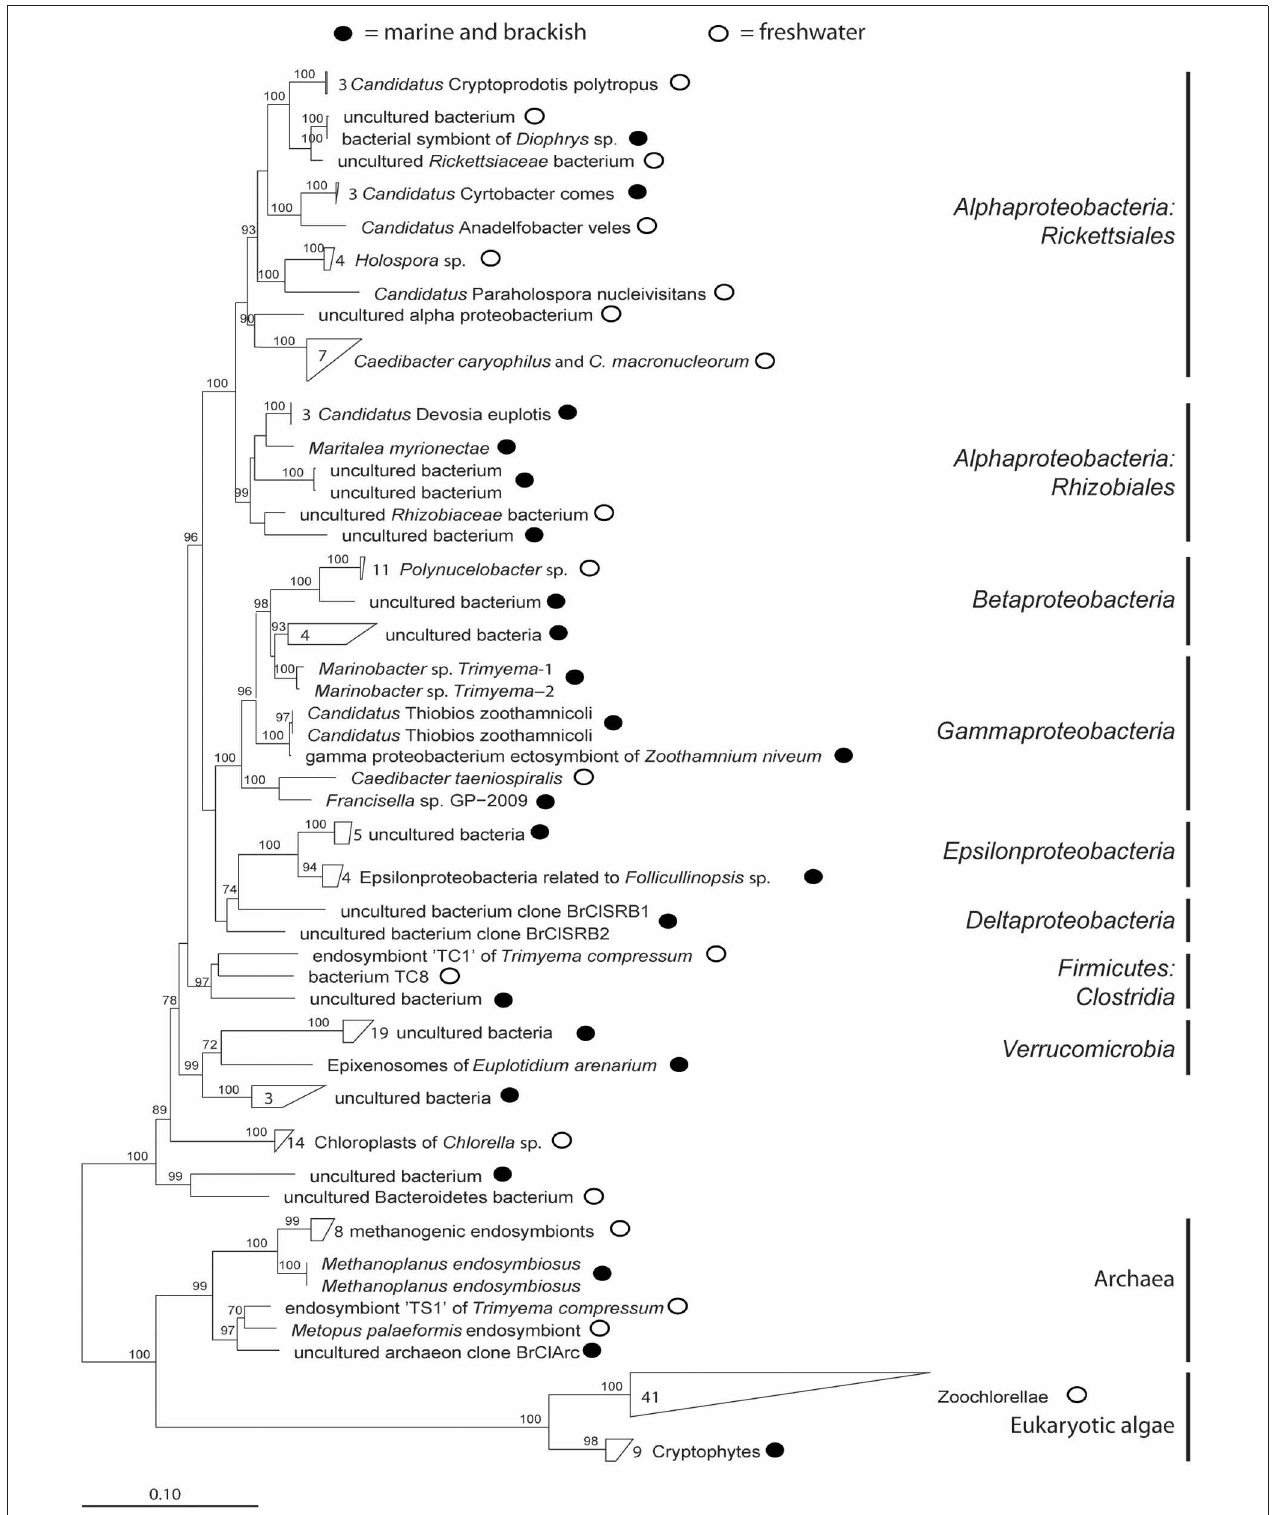
FIGURE 2 | Phylogenetic tree of published symbionts in aquatic ciliates (accession numbers are given in Table A1). The tree was calculated with FastTree using the aligned sequences from ARB-SILVA. Bootstrap values are only given ≥ 70.